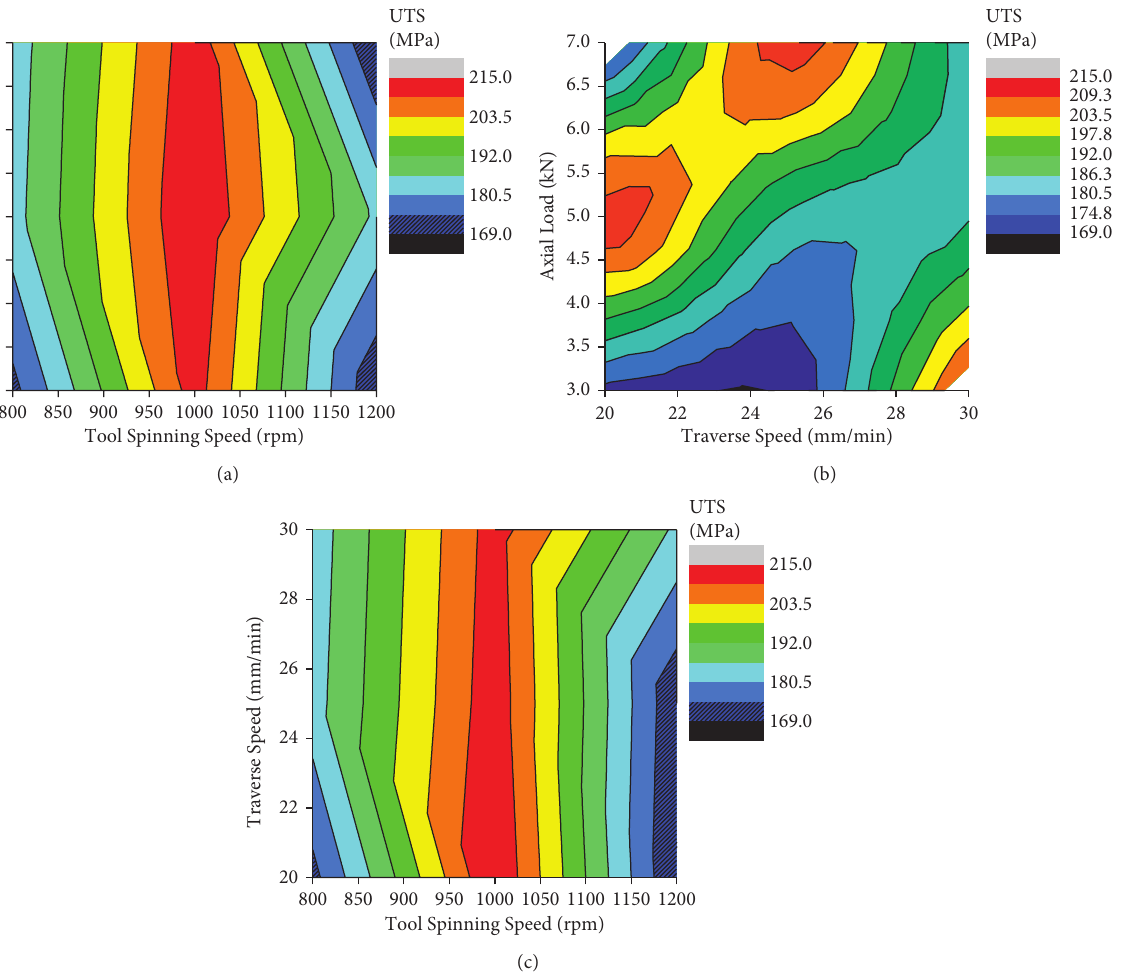
Figure 5: Contour plot of tensile strength for (a) tool spinning speed versus axial load, (b) traverse speed versus axial load, and (c) tool spinning speed versus traverse speed.